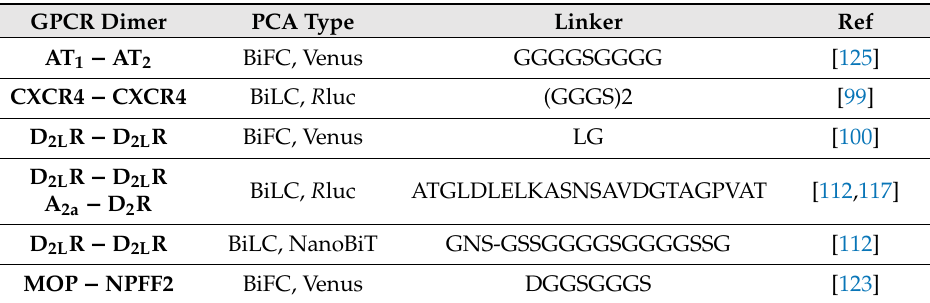
Table 4. Linker sequences applied in PCA assays for studying GPCR